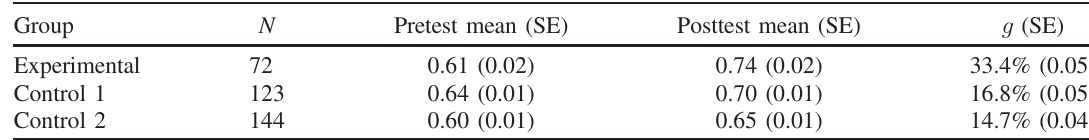
TABLE II. Control and experimental group g values.